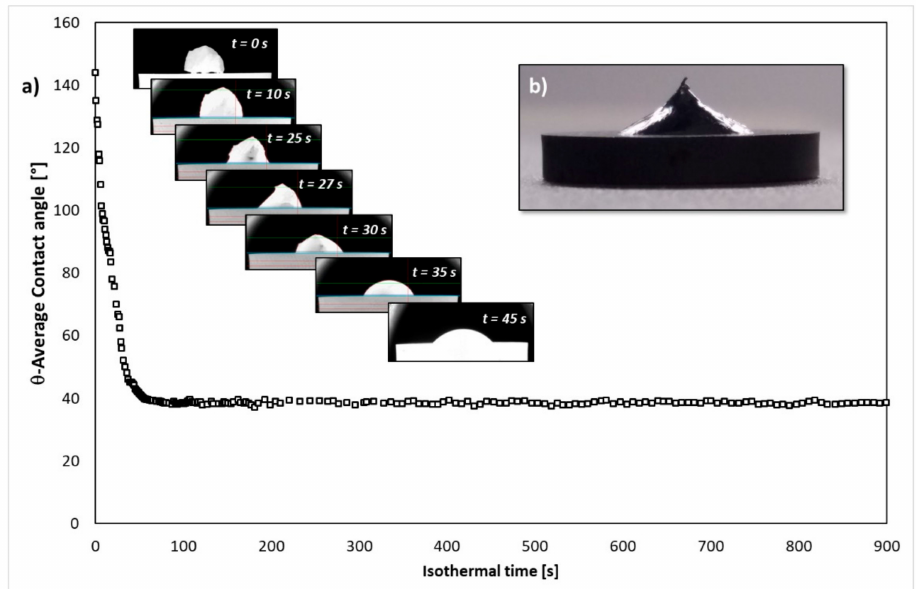
Figure 2. Wetting kinetics for the liquid Si / GC (glassy carbon) system observed at T = 1450 ◦ C under a static Ar atmosphere for 15 min: ( a ) contact angle values and time sequence images of the liquid Si-drop spreading on GC; ( b ) the Si / GC sample after the wetting experiment.